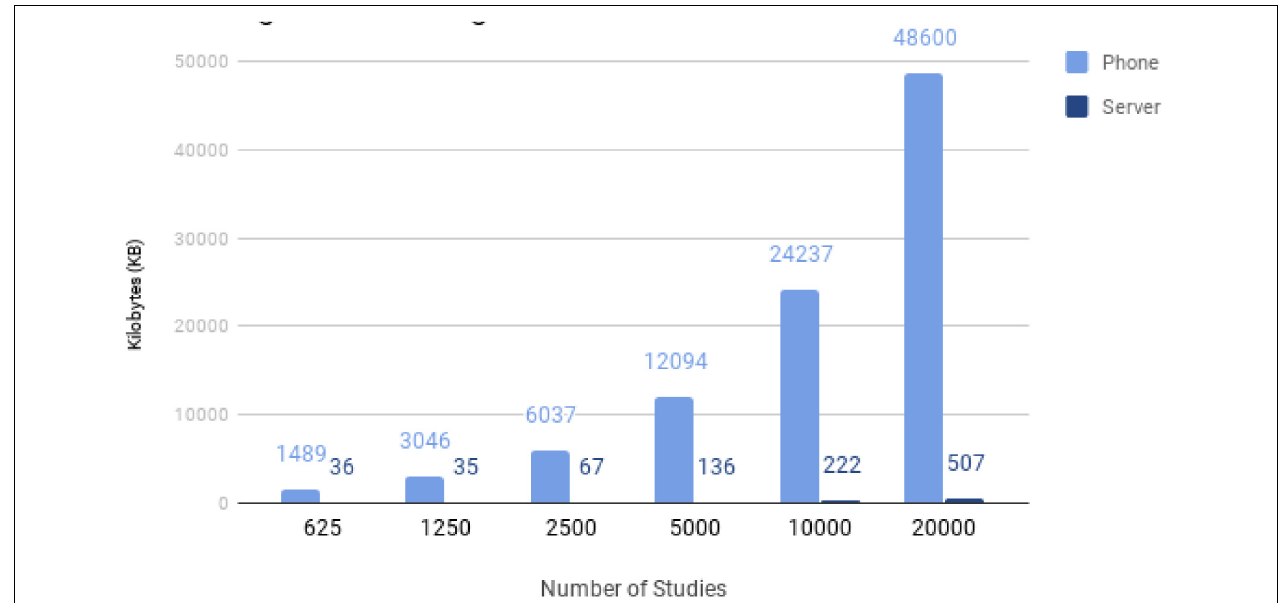
FIGURE 2 | Matching criteria graph Size vs. total